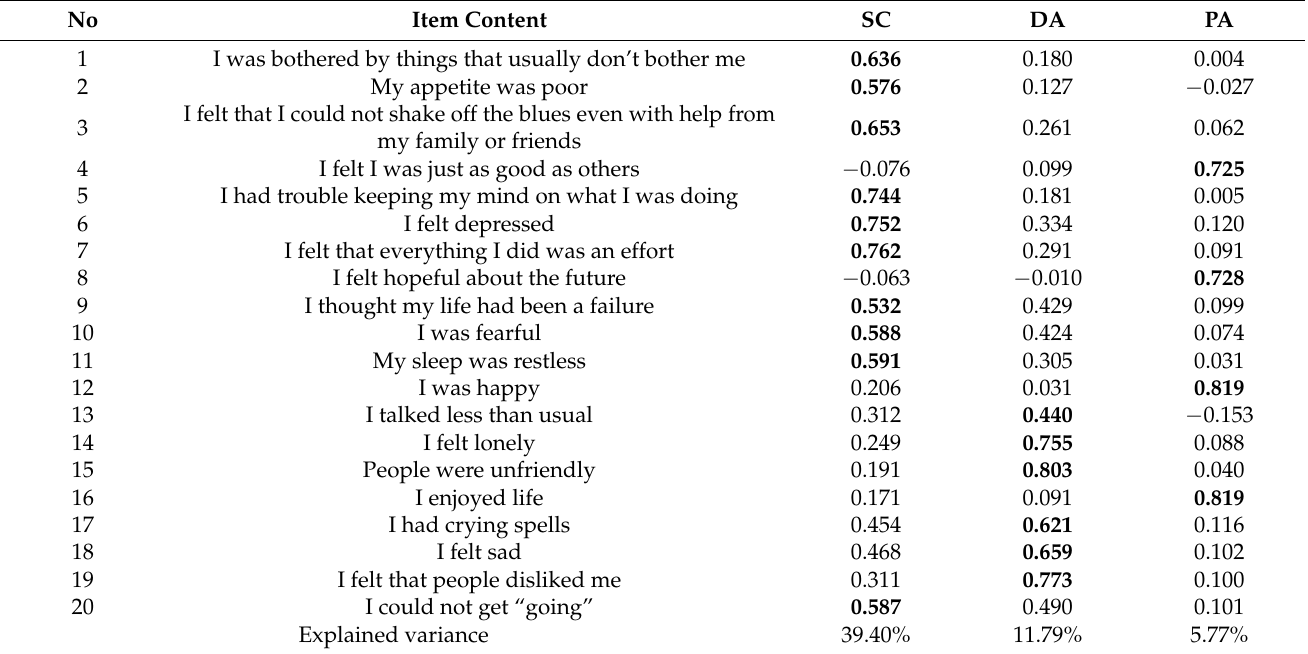
Table 2. Factor loadings for exploratory factor analysis using the half sample A at Wave 1 ( n =